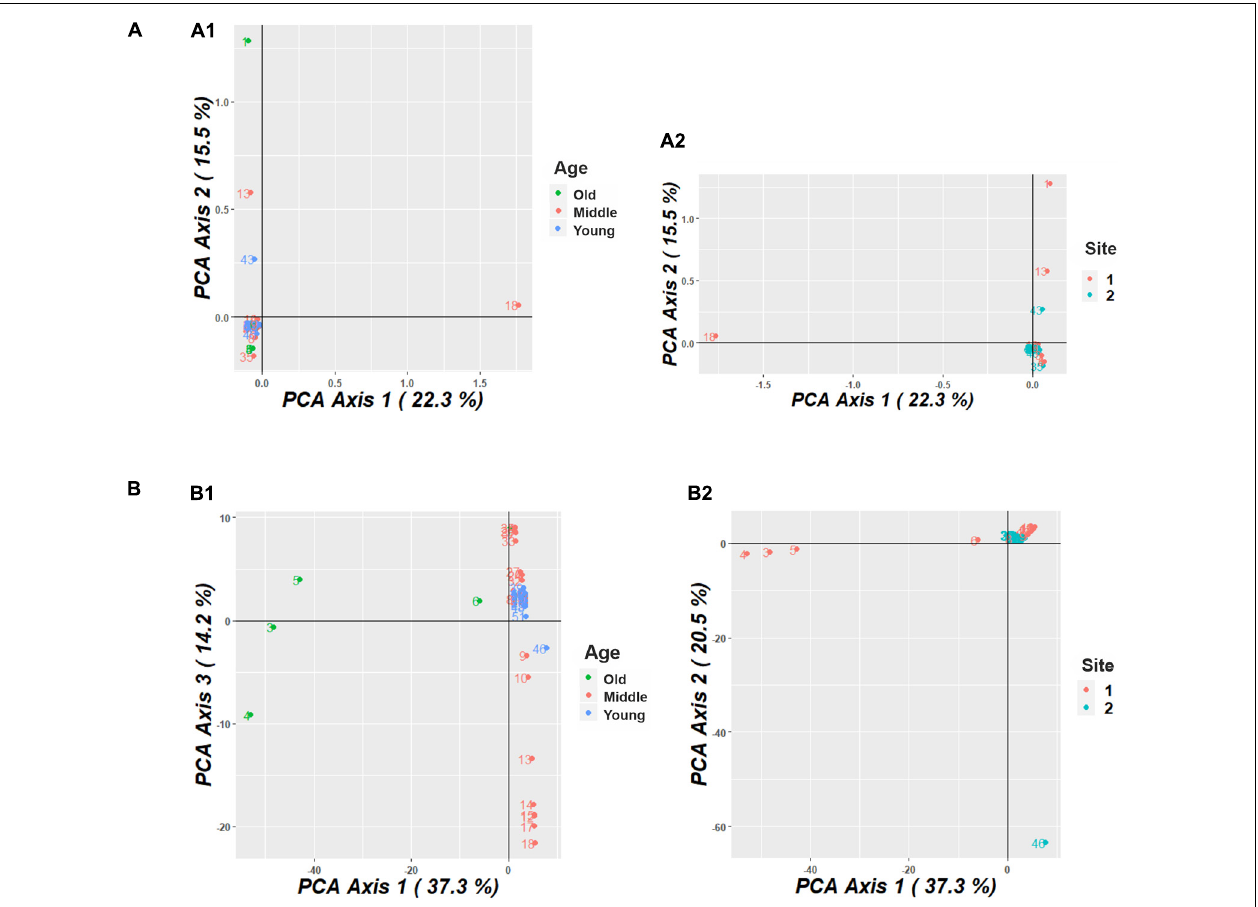
FIGURE 5 | (A) Principal coordinate analysis (PCoA) plot, based on SNP markers, showing the distribution of M. argun samples from (A1) three generations (old, middle-age, and young) and (A2) two collection sites in Sudan. (B) Principal coordinate analysis (PCoA) plot, based on SilicoDArT markers, showing the distribution of M . argun samples from (B1) three generations and (B2) two collection